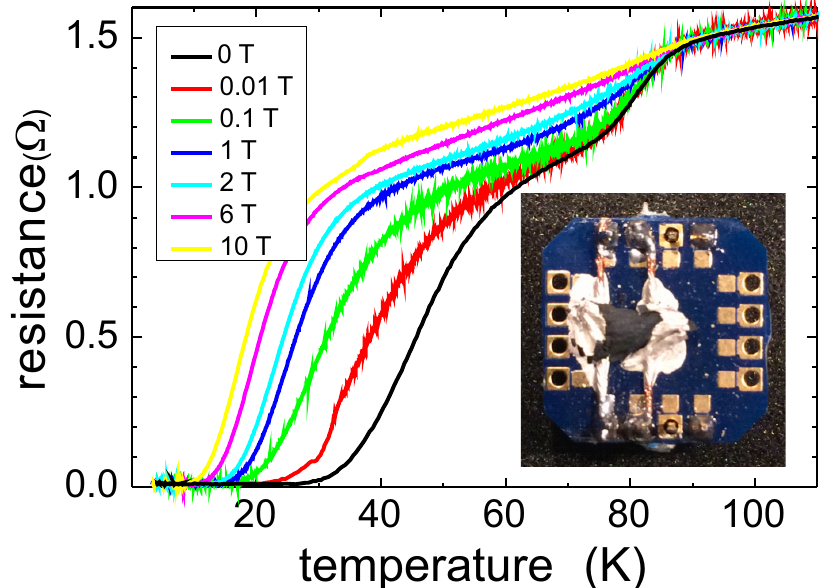
Figure 7. Resistance as function of temperature for various applied magnetic fields (0–10 T). The inset gives an optical image of the nanofiber mat sample on the sample holder.